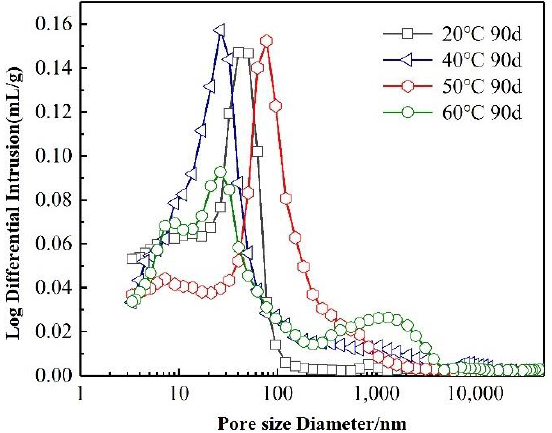
Figure 4. Pore structure of the SRPC at different temperatures. Table 6. Aperture ratio of the SRPC.